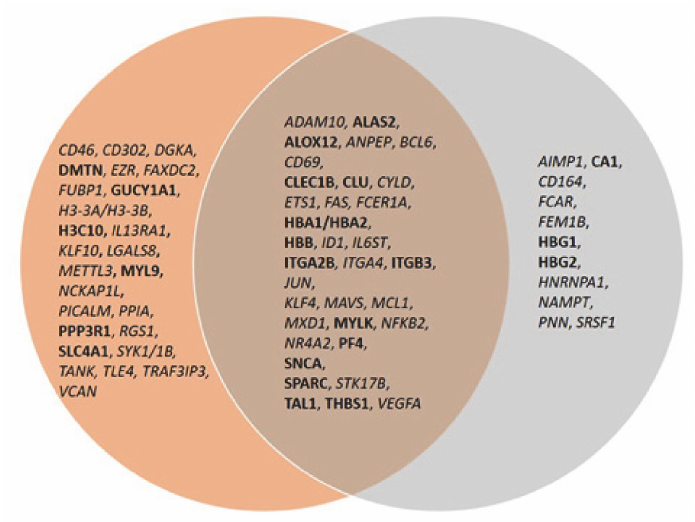
Figure 6. Venn diagram of common genes among the anemia and inflammation networks. Upregu- lated genes are in bold font, downregulated genes in italic.